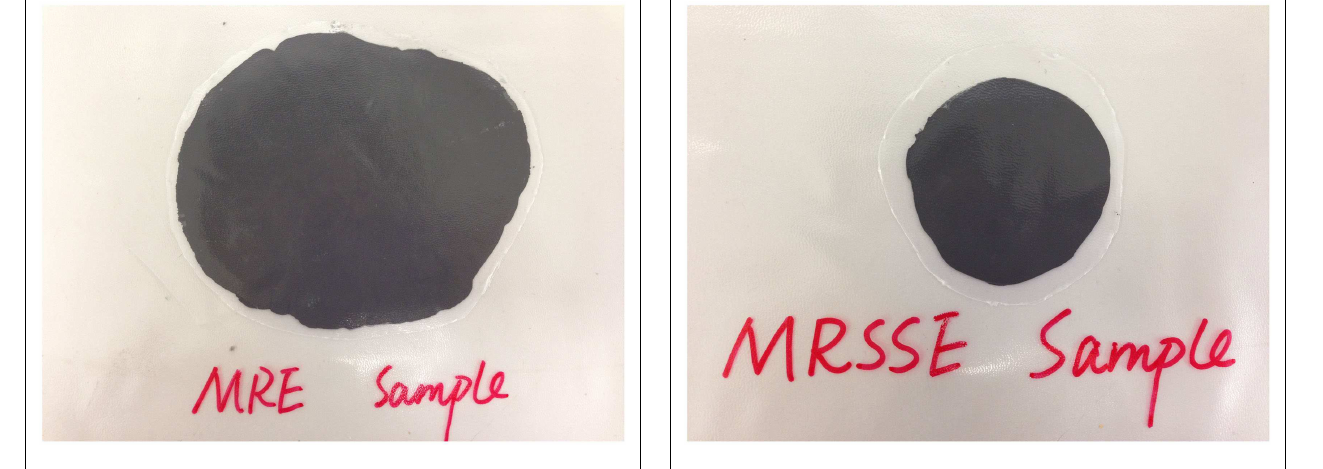
FIGURE 2 | Picture of MRSSE sample